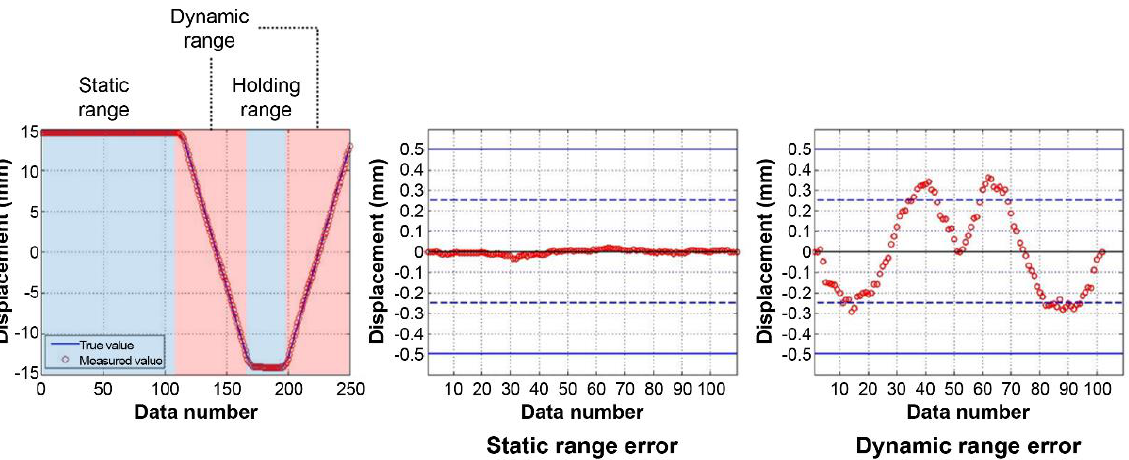
Figure 5. X -axis movement signal comparison (stage control vs. measured displacement) and errors of statics and dynamics ranges.